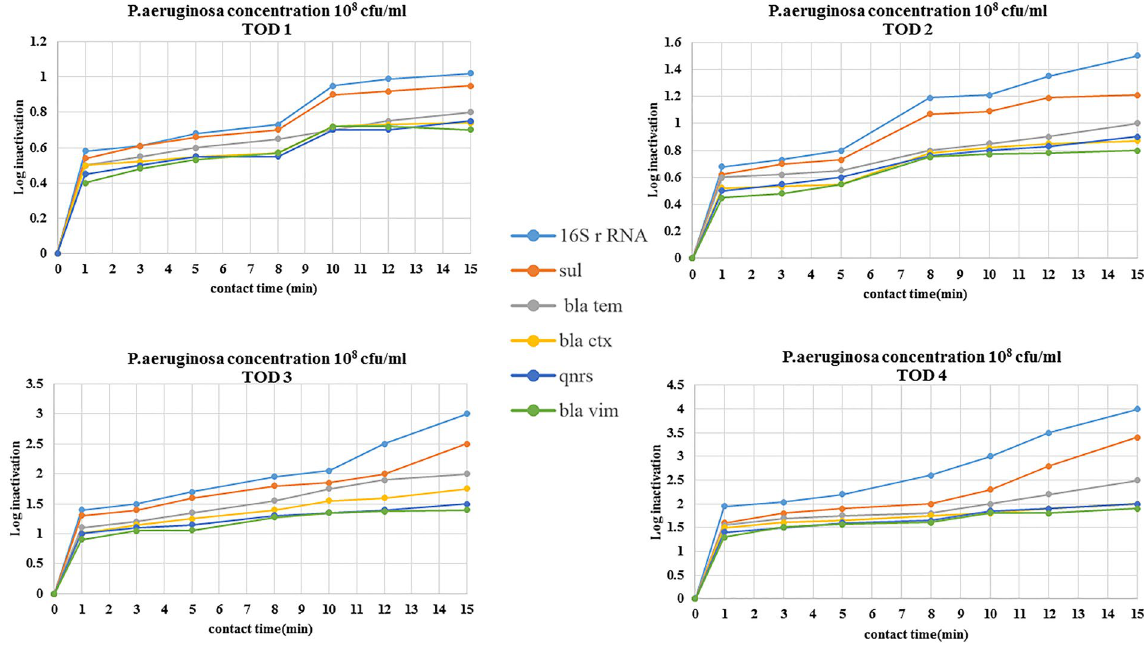
Figure 5. Removal efficiencies of antibiotic resistance genes in Pseudomonas aeruginosa by ozonation at ozone doses of 11–45 mg/l (TOD1 = 11 mg/l, TOD2 = 25 mg/l, TOD3 = 37 mg/l, TOD4 = 45